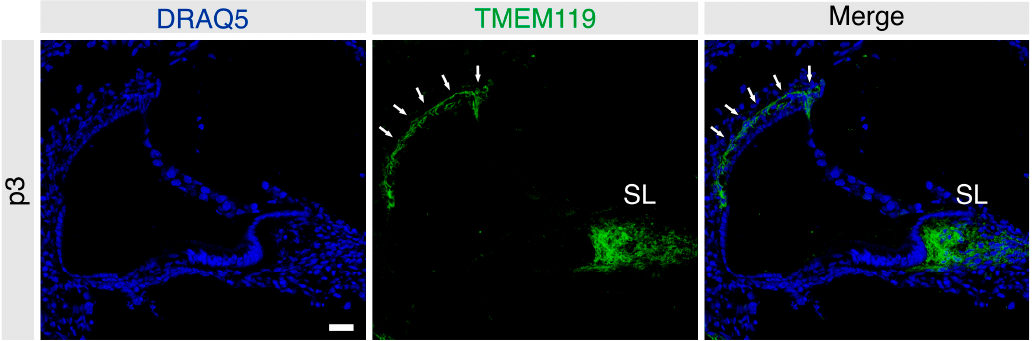
Figure 1. Frozen sections of the immature mouse cochlea at p3 labeled for TMEM119 (green). Nuclei were counterstained with DRAQ5 (blue). TMEM119 protein expression was detected in the inter- mediate and basal cells of the stria vascularis (solid white arrows) and the fi brocytes of the spiral limbus (SL) at p3. Scale bar: 20 µm. TMEM119 was not detected in the vicinity of the organ of Corti. TMEM119 localiza- tion contrasted with that of Iba1 on macrophages sca tt ered across various cochlear regions (Figure S1). Double labeling with an anti-Iba1 antibody revealed markedly di ff erent local- ization pa tt erns, with only minor overlap among cells of the spiral limbus fi brocytes and the stria vascularis (Figure 2). The results indicated that TMEM119-positive cells do not express macrophage markers in the postnatal murine cochlea nor represent a subset of Iba1-positive macrophages.